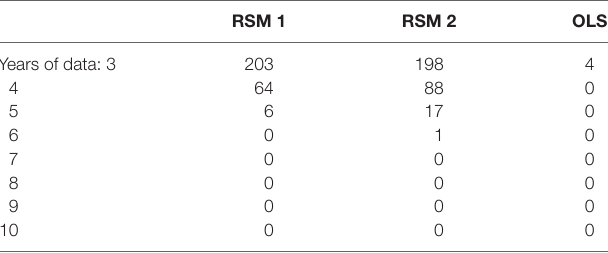
Simulation 2 (negatively skewed). RSM 1 and RSM 2 refer to estimating the correlation between the random variables (1) and fixing it at zero (2).